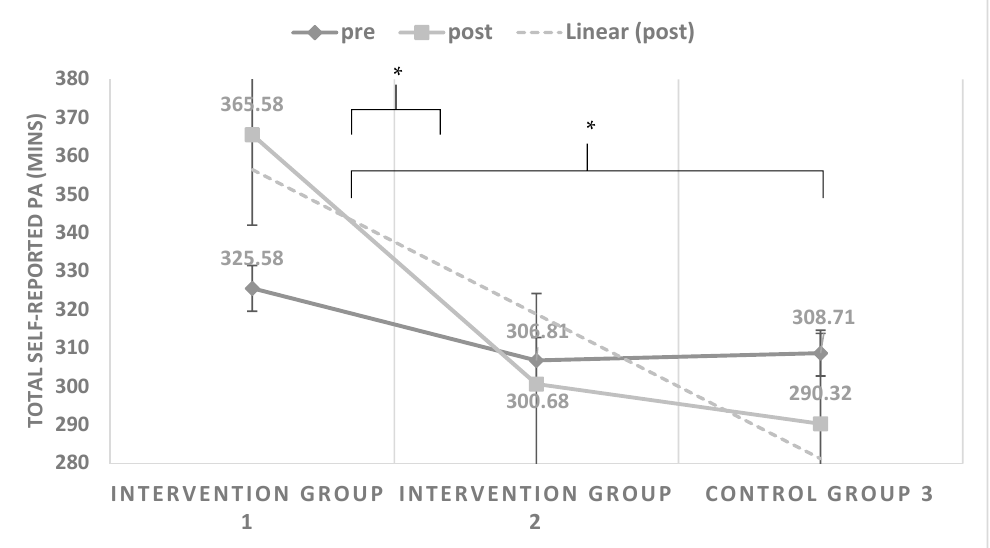
Figure 1. Comparison of the mean self-reported minutes of MVPA over time (pre to post) by group. * Significant difference between group 1 ( p ≤ 0.003) and group 2 ( p ≤ 0.002) and between group 1 and 3 ( p ≤ 0.004).